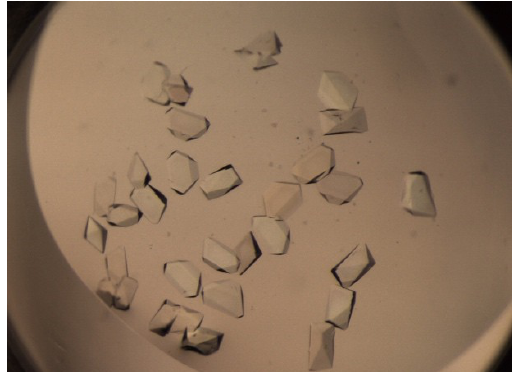
Figure 8. Crystals of CtPFD.